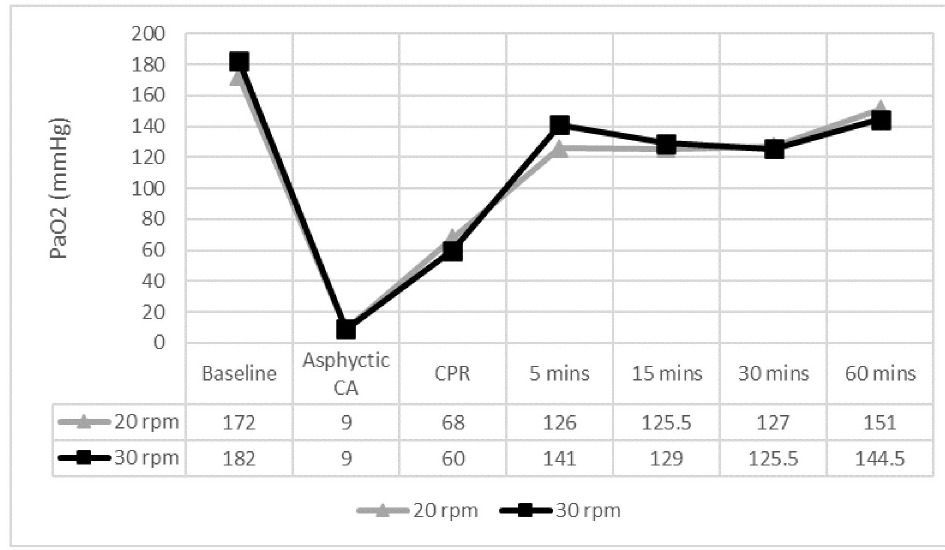
Fig 4. PaO2 levels throughout the experiment. ✩ p < 0.05. PaO2: O2 arterial pressure; CA: cardiac arrest; CPR: cardiopulmonary resuscitation; mins: minutes. 5 mins to 60 mins: time after ROSC.